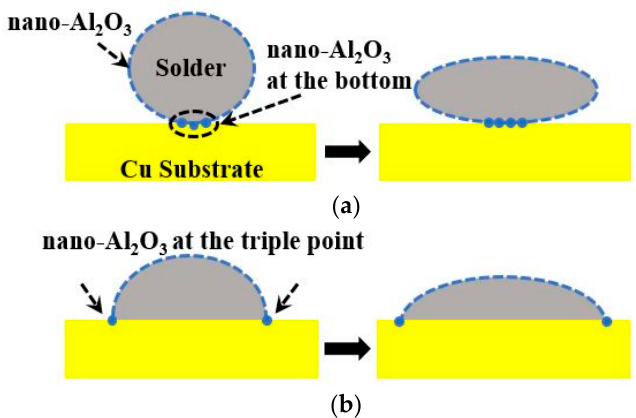
Figure 5. Schematic diagram of the effect of Al 2 O 3 nanoparticles on the wetting and spreading: ( a ) Contribution to wetting; ( b ) contribution to spreading [39].